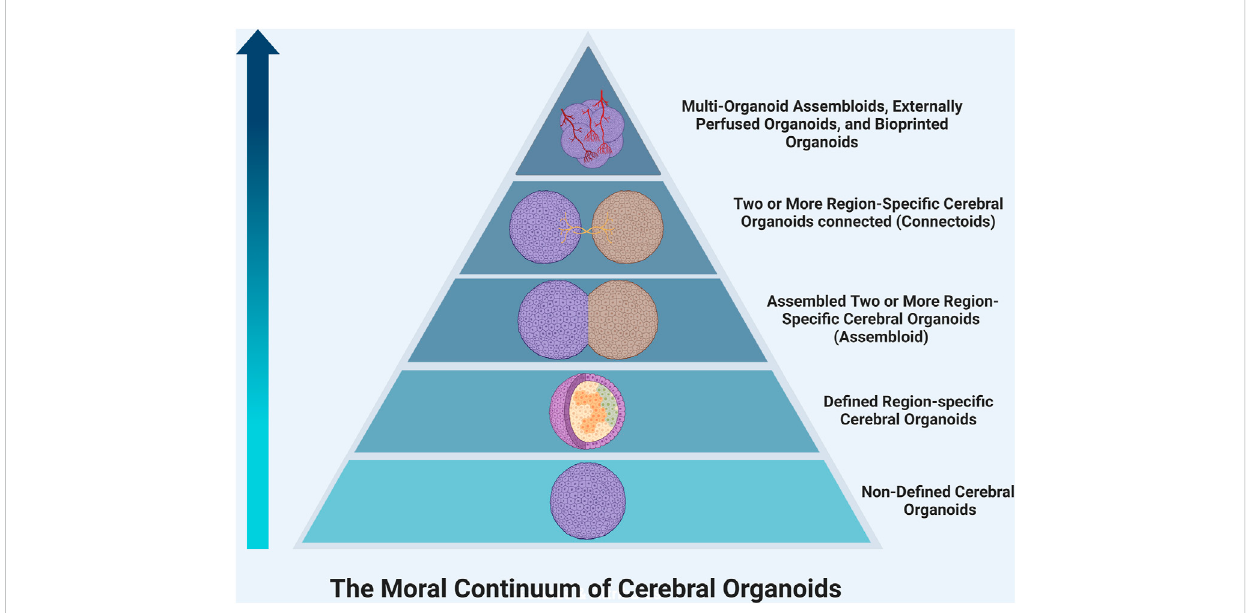
FIGURE 1 The continuum of moral signi fi cance in organoid research. Organoids vary widely in their complexity, so it becomes important to consider if, and where, different organoids fall on this continuum of moral signi fi cance. For example, an organoid using a protocol, which generates a cerebral organoid withvaryingpopulationsofcellsfromdifferentbrainregions,wouldlikelybeloweronthehierarchythanaregion-speci fi corganoid,whichcontainsmore mature organization. Moving up the pyramid, co-culturing region-speci fi c organoids creates reciprocal connections that begin to form primitive circuits. Connectoids offer even further maturation of function. The addition of more region-speci fi c organoids, non-neural cell types like endothelial cells or microglia, external perfusion systems, and bioengineering will allow organoids to grow in size, cell number, and synaptic density. This will continue to increase the complexity and thus the moral signi fi cance of such